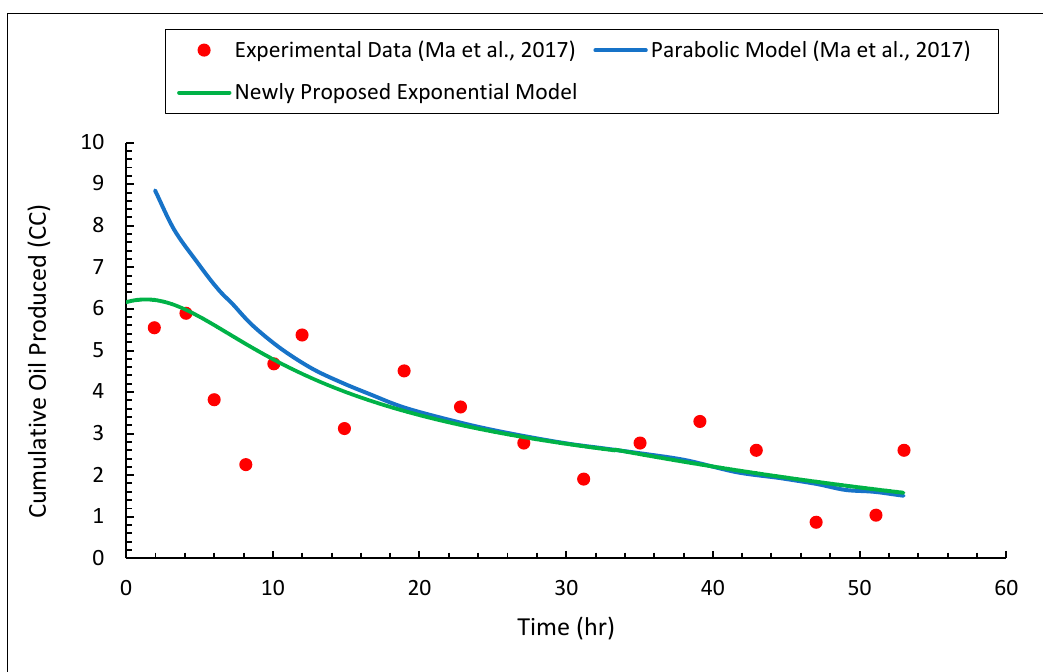
Figure 25. Comparison of the oil production rate estimated by the newly proposed exponential model, experimentally measured oil production rate [3], and oil production rate estimated by the parabolic model proposed by Ma et al. [3] in test #1.